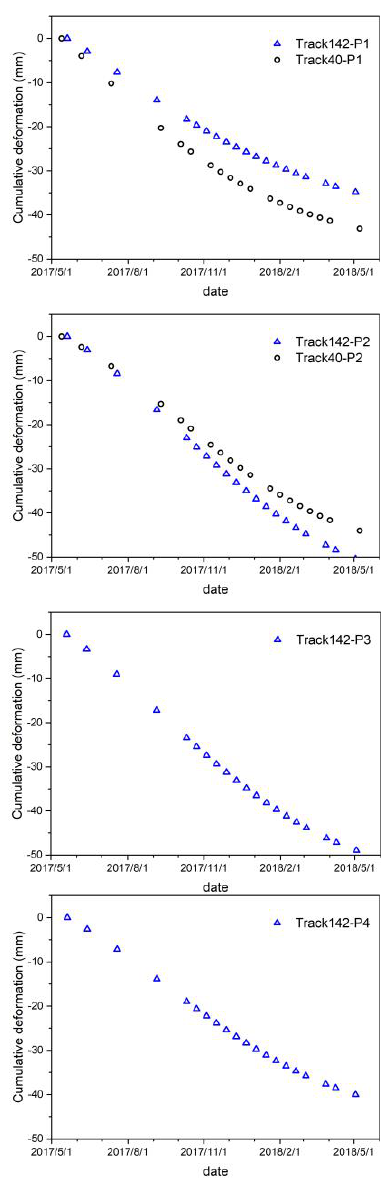
Table 5. Statistics of 24 major deformation areas Four points with serious deformation were selected, as shown in Figure 6. It can be seen that the deformation trends of track 40 and track 142 are basically consistent at the subsidence points of P1 and P2.